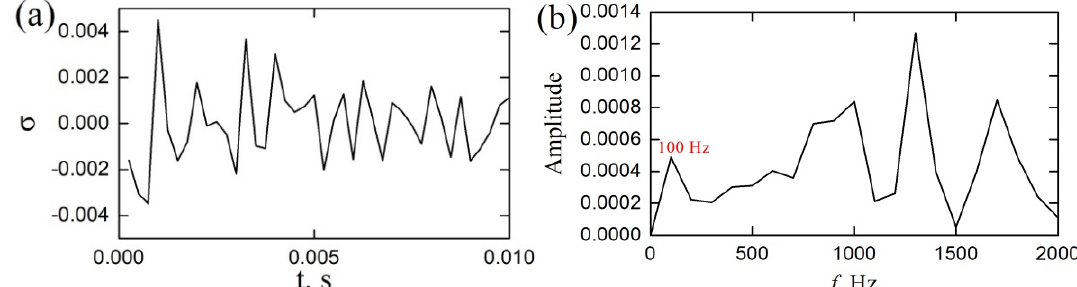
Figure 11. ( a ) The unsteady fluctuation and ( b ) the spectrum of the wall static pressure probed at position p5.